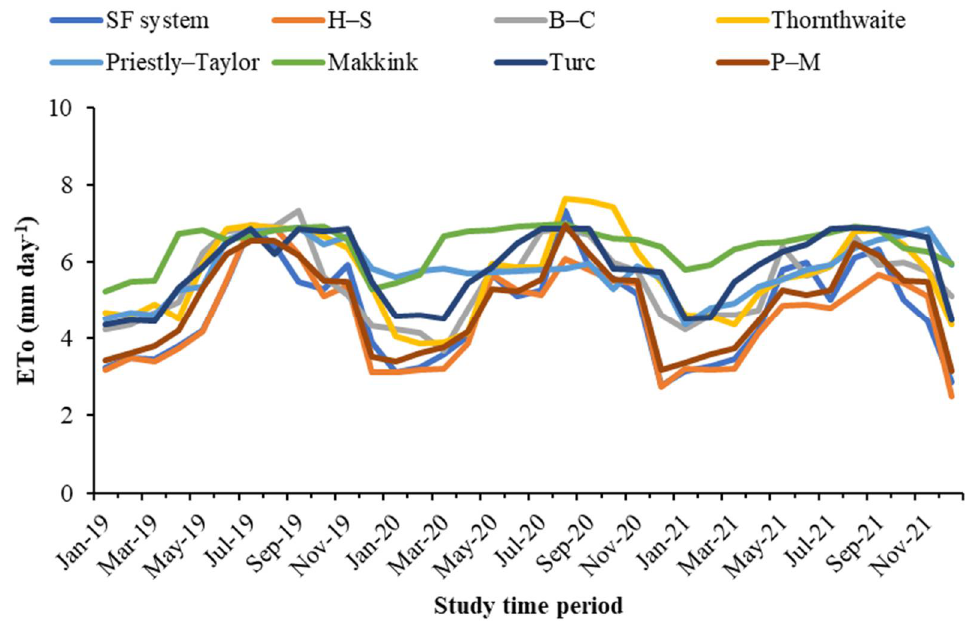
Figure 4. Comparison of the 3-year daily solar fertigation system and API (temperature- and radiation-based) models with the standard combination-based FAO P–M model in Molise.